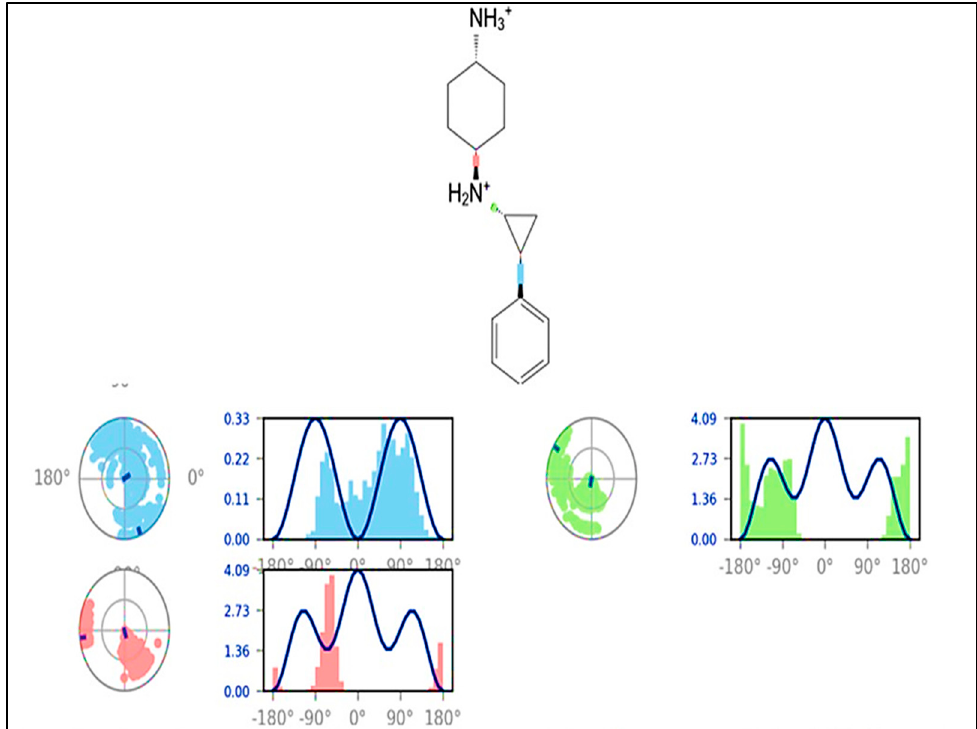
Figure 23. Ligand torsion profile of LSD-compound 1 displayed during 150 ns of simulation 1. Molecular Mechanics Generalized Born and Surface Area (MMGBSA) calculations. The MMGBSA method is often used to determine the binding energy of ligands to protein